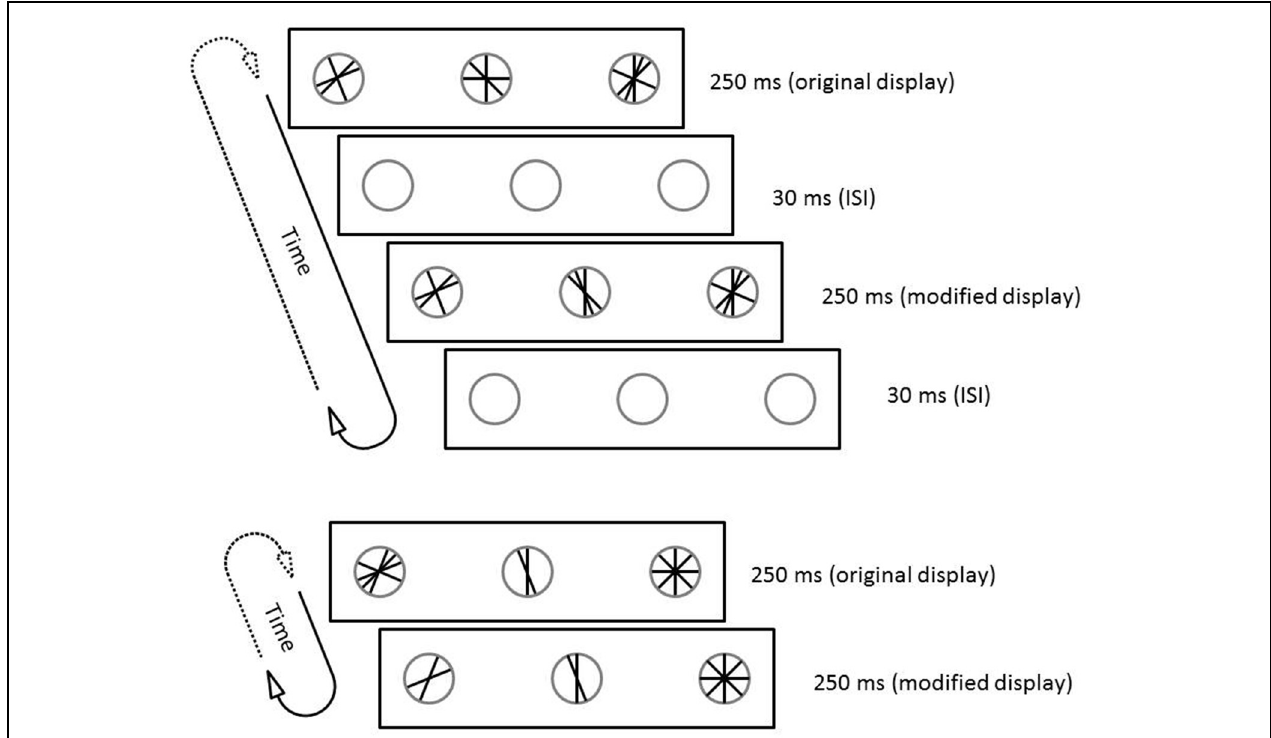
FIGURE 1 | Structure of a trial with an inter-stimulus interval (ISI; top) and without an ISI (bottom). Both trials depict a change of two line features. (Top) the change is on the center key. (Bottom) , the change is on the left key.